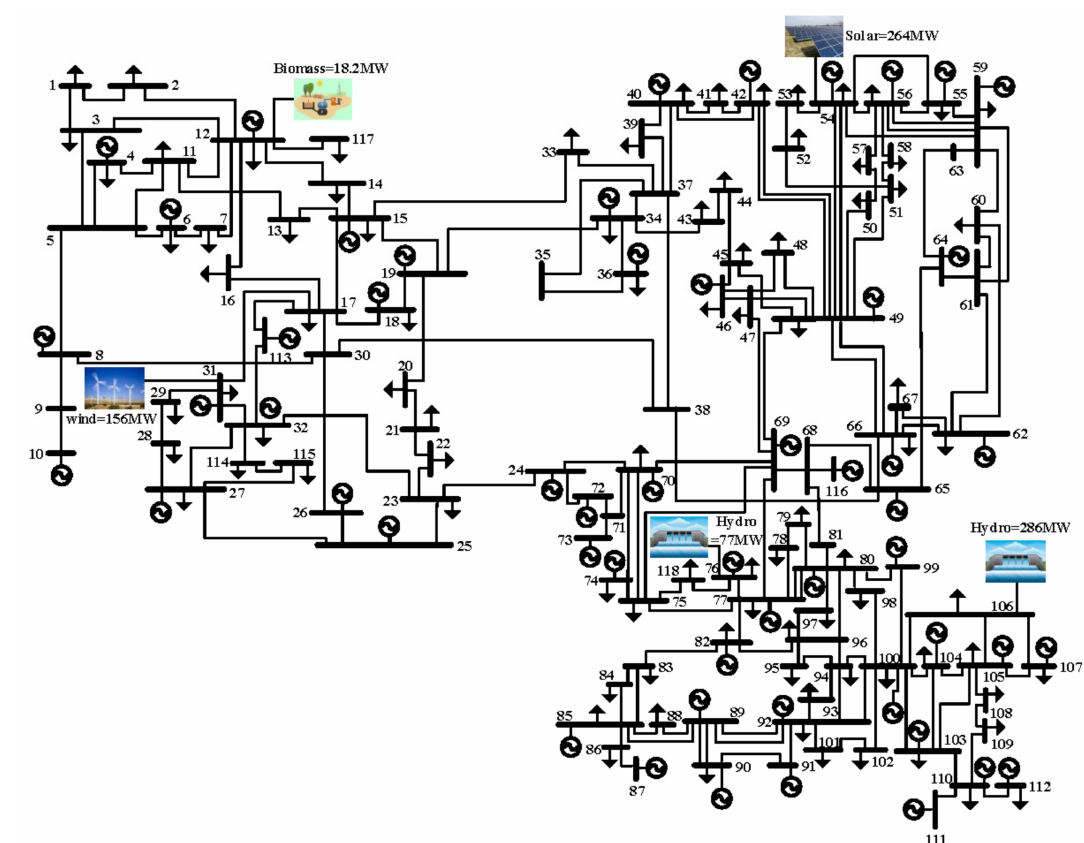
Figure 3. Single-line diagram of IEEE 118-bus test